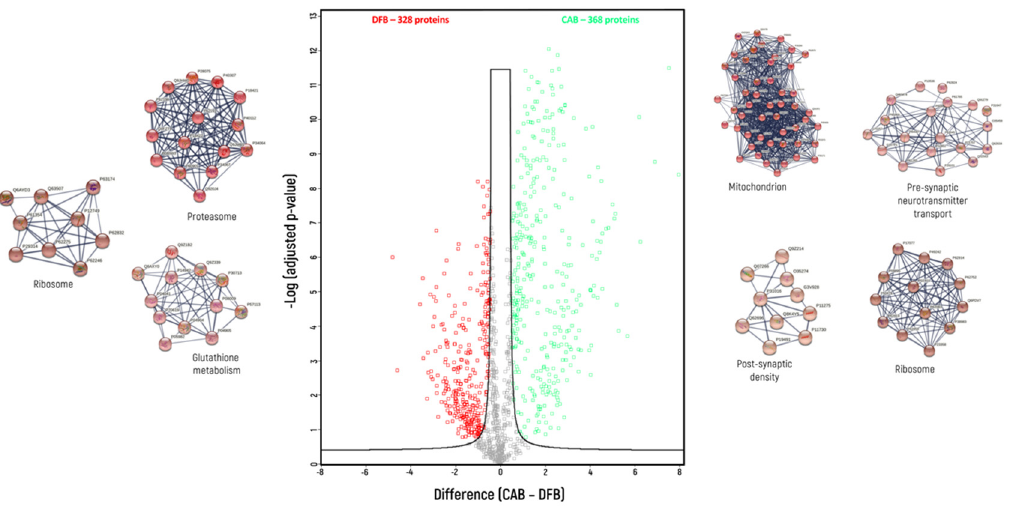
Figure 3. Volcano plot of proteins for which different levels were found between DB and DFB homogenization buffers (blue—overrepresented in DB buffer; red—overrepresented in DFB buffer); indicated are protein clusters which were identified by GO analysis with application of Markov clustering method (FDR < 0.01).